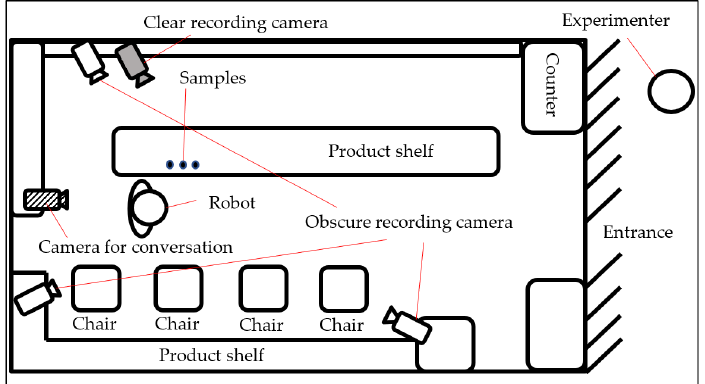
Figure 1. Top-down view of the shop, Dintora, displaying all camera locations.